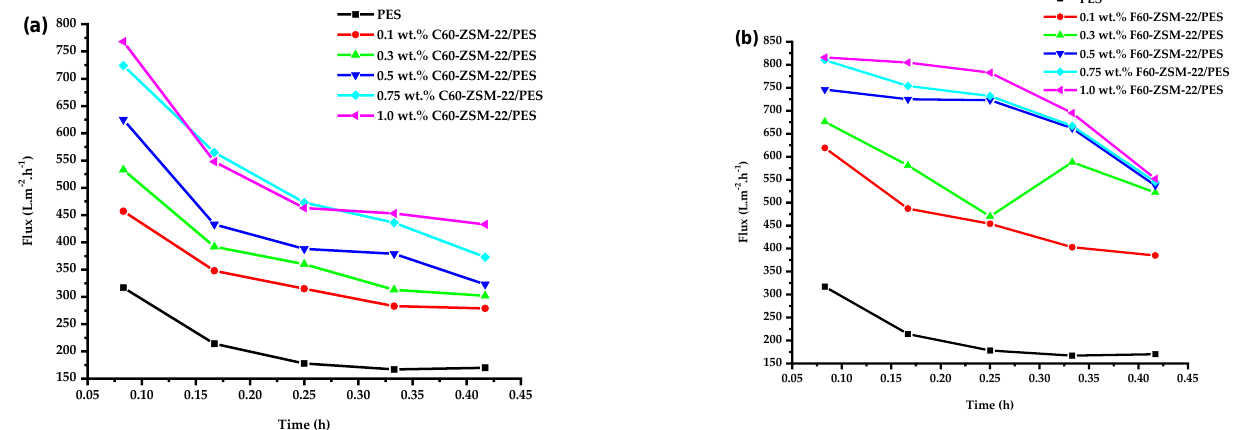
Figure 9. Pure water flux analysis of nanofiltration membranes prepared via phase inversion to nominal wt.% loadings of 0, 0.1, 0.3, 0.5, 0.75, and 1.0 using ZSM-22 zeolite as nanoadditives: ( a ) C60-ZSM-22/PES and ( b ) F60-ZSM-22/PES.